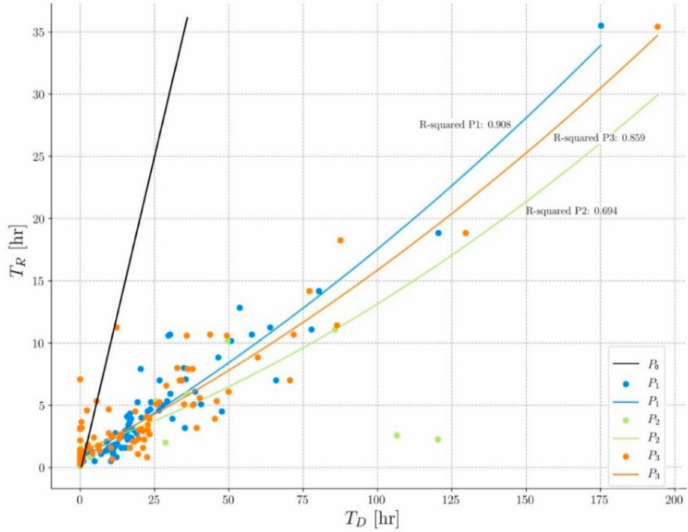
Figure 4. Relationship between drainage time (T D ) and rainfall time (T R